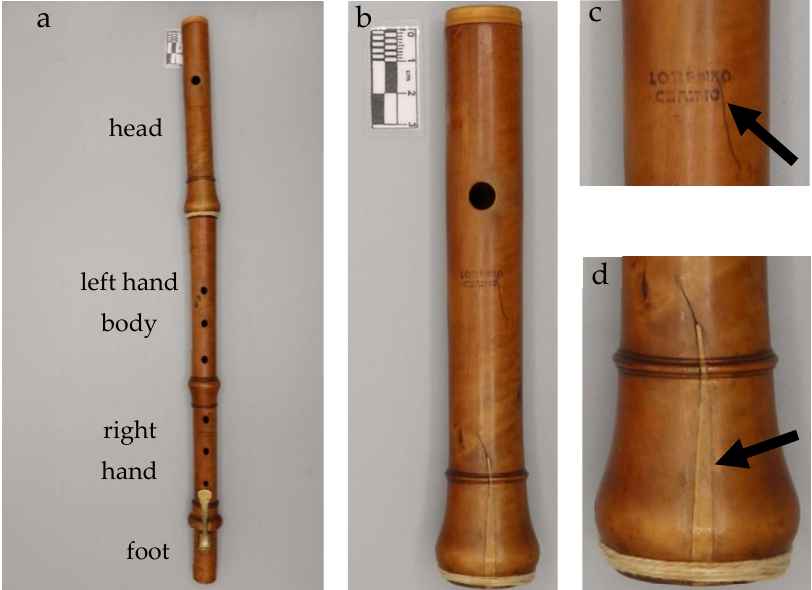
Figure 2. The analyzed woodwind instrument: ( a ) Transverse Flute (tone in F) produced by Lorenzo Cerino; ( b ) detail of the Transverse Flute head, in which it is possible to observe the manufacturer’s signature (( c ), black arrow) and the crack (( d ), black arrow).